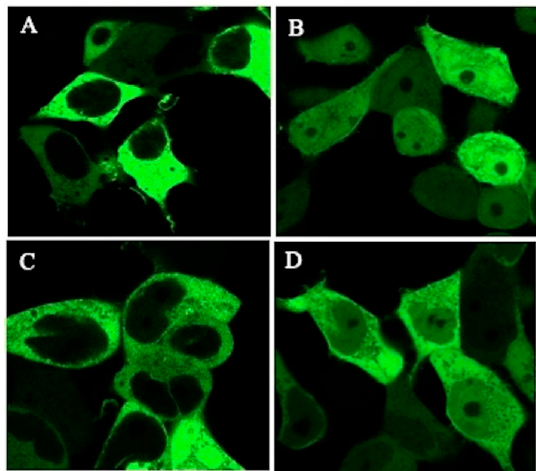
Figure 4. Intracellular localization of transfected TSC-22 (TSC22D1-2) and truncation mutants (TSC-22N, TSC-22C (TSC22(86)). ( A , B ): TSC-22 under ( A ) unstimulated conditions and ( B ) after treatment with phleomycin (0. 5 mM) for 12 h. ( C ): TSC-22N. ( D ): TSC-22C (TSC22(86)).